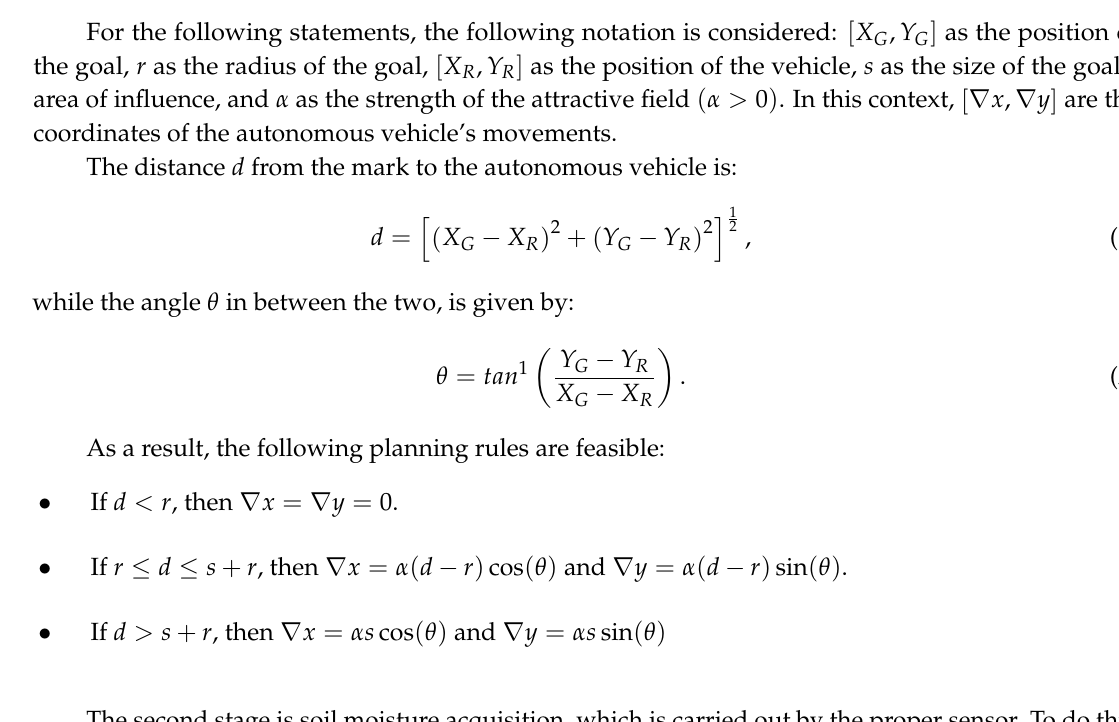
Figure 3. Potential field action vectors, white circle (goal), and blue region (potential